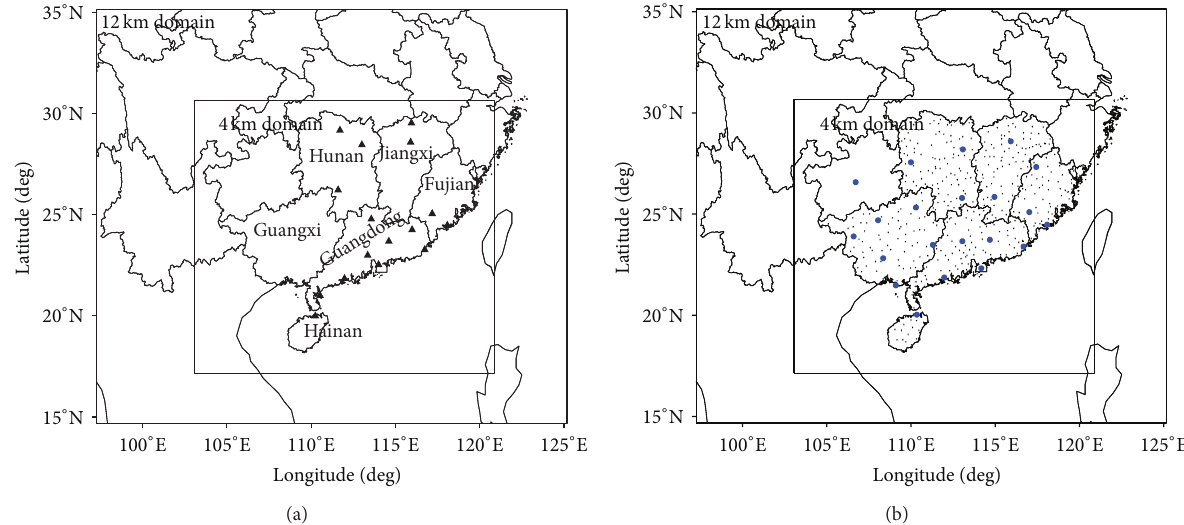
Figure 1: Model domains and locations of (a) radar (black triangles) sites, and (b) AWS (small black dots), and radiosonde (big blue dots) sites.